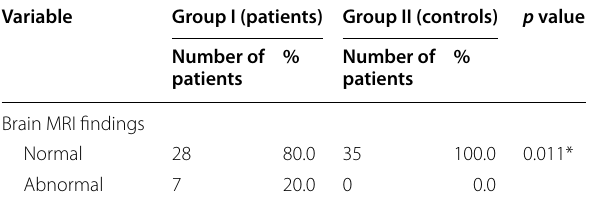
Table 3 Comparison of brain MRI findings between the studied groups